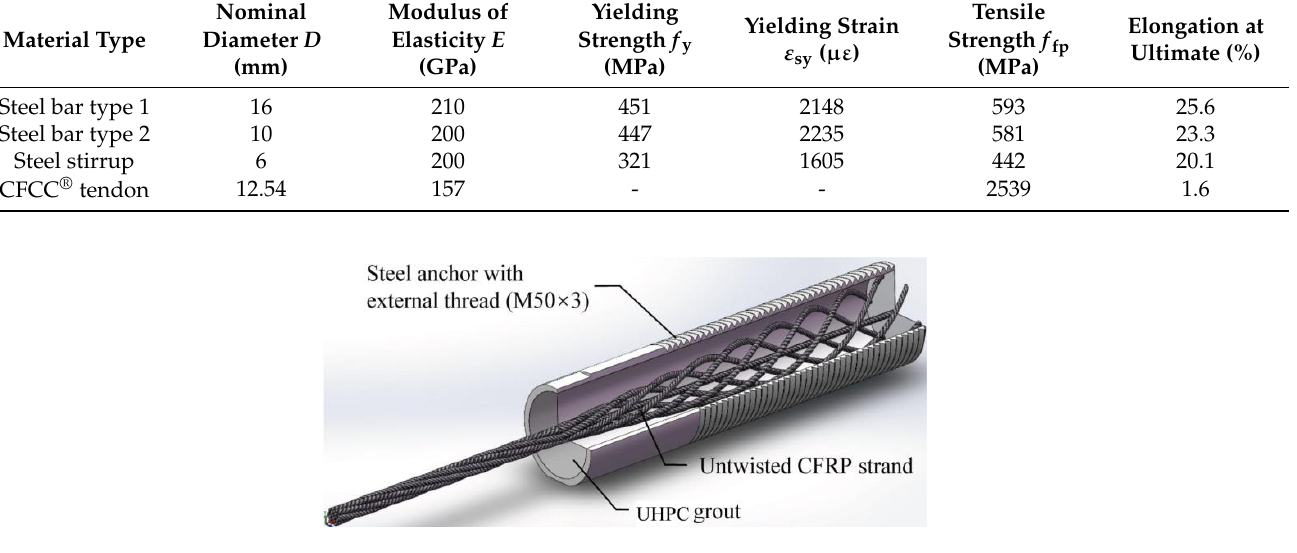
Figure 3. Details of the bond-type anchor.